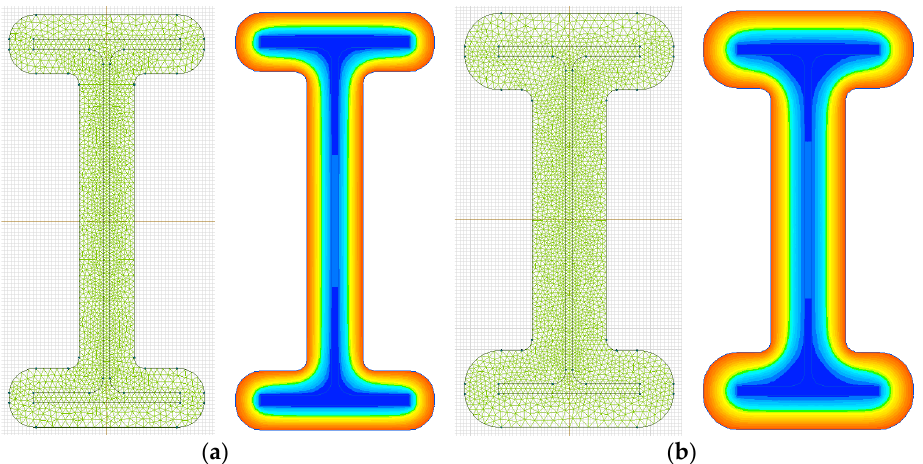
Figure 6. Scheme of sample with coating No. 2.1 and visualization of its heating ( a ); scheme of sample with coating No. 2.2 and visualization of its heating ( b ). Figure 7. Temperature scale in standard fire regime, ° С . Figure 8. Temperature scale in hydrocarbon fire regime, ° С .